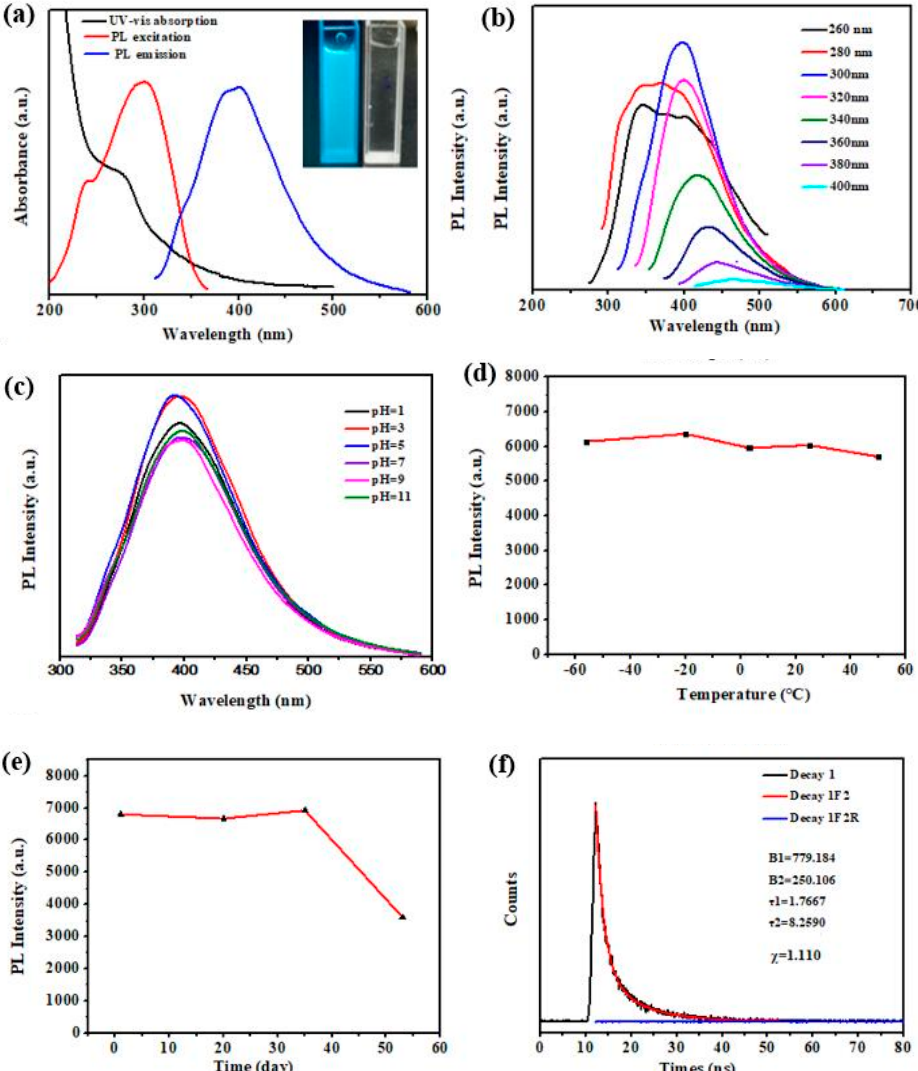
Figure 4. ( a ) UV–Vis absorption and fluorescence excitation and emission spectra of N-L-CQDs. Inset: the images of N-L-CQDs in aqueous solution under UV light of 365 nm (left) and sunlight (right). ( b ) PL emission spectra of N-L-CQDs excited by various wavelengths ranging from 260 nm to 400 nm with 20 nm increments. ( c ) Effect of pH values on PL intensity of N-LCQDs. ( d ) PL intensity change of N-L-CQDs solutions at different temperatures. ( e ) Effect of storage time on fluorescence intensity of N-L-CQDs solutions. ( f ) PL lifetime data of the N-L- CQDs.